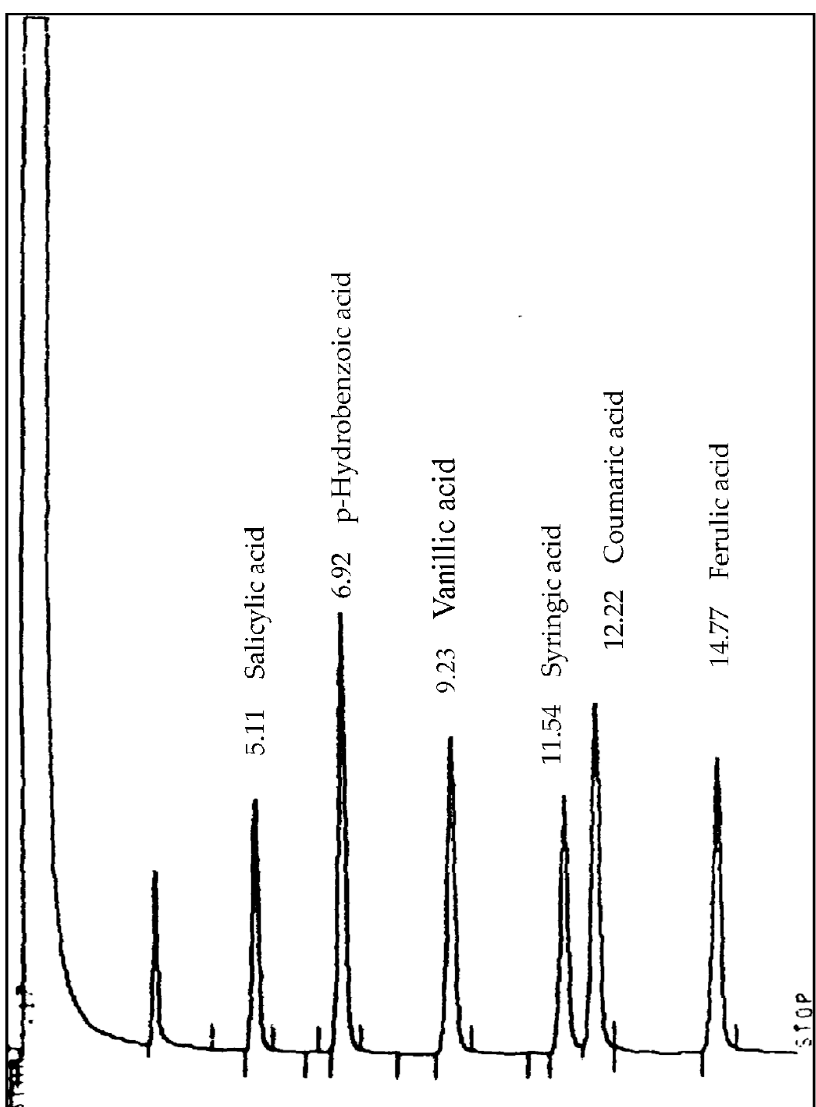
Figure 2. Chromatogram of standard phenolic compounds.